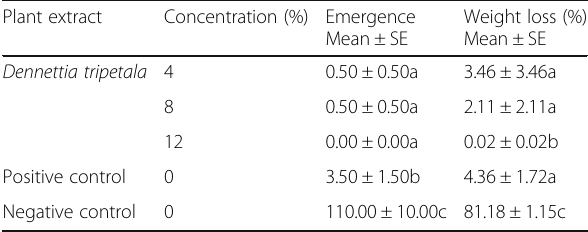
Table 2 Pesticidal effect of ethanolic extract of D. tripetala on emergence and weight loss